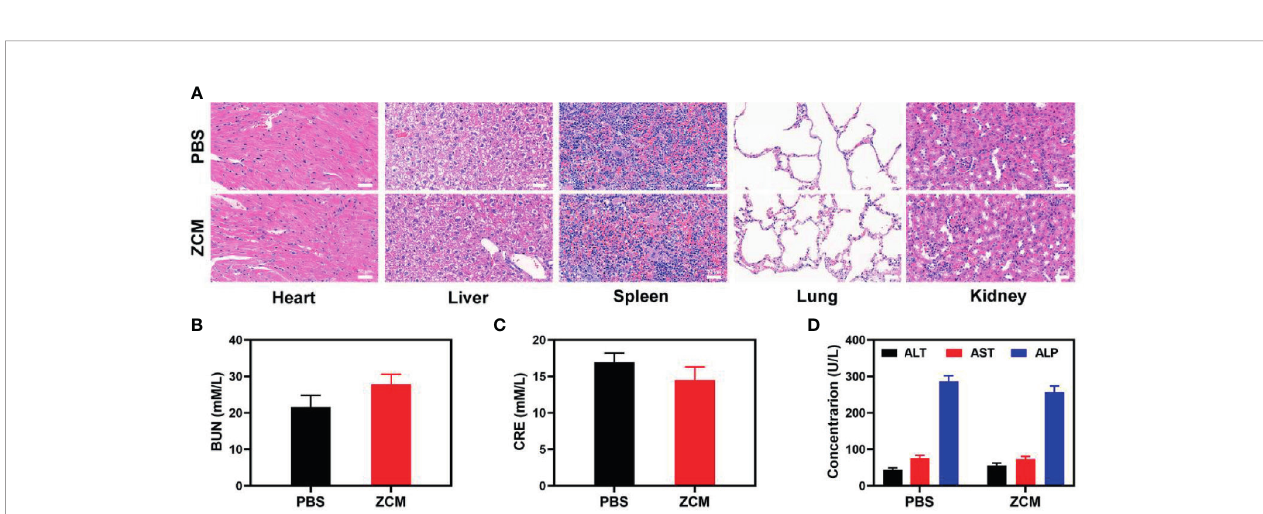
FIGURE 4 | (A) Histopathologic examination of the tissues including the heart, liver, spleen, lung, and kidney from tumor-bearing mice after PBS or ZCM treatment. (B) Blood biochemistry data for kidney function marker BUN. (C) Blood biochemistry data including kidney function marker CRE. (D) Liver function markers: ALT, AST, and ALP.